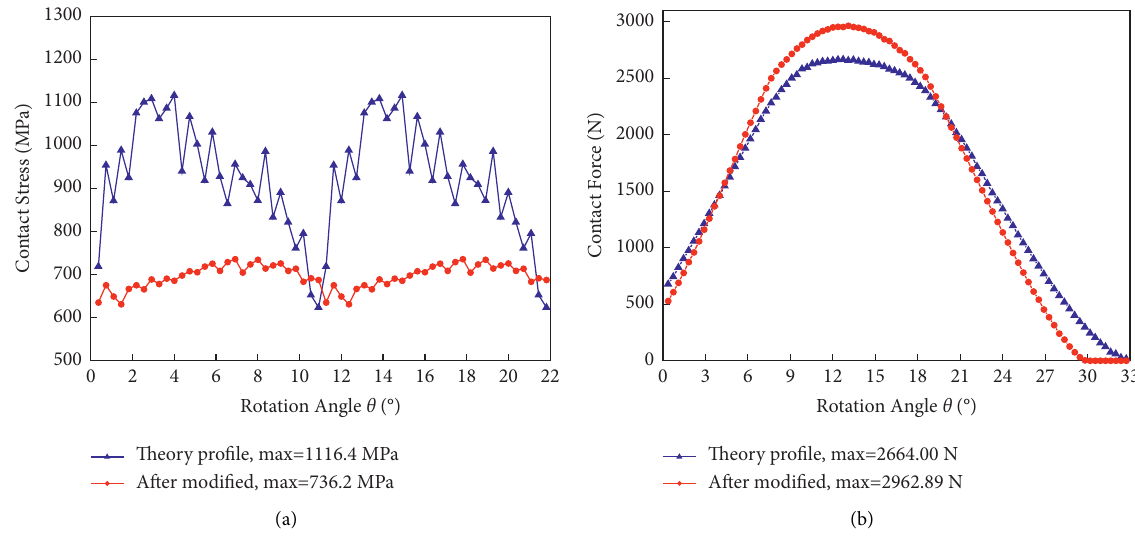
Figure 8: Contact stress and contact force for a single tooth. (a) Contact stress. (b) Contact